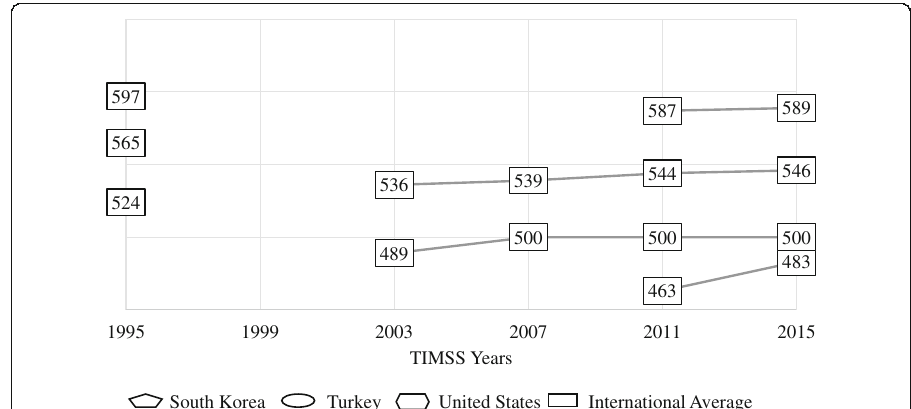
Fig. 1 Fourth Graders ’ Science Achievement in TIMSS in South Korea, Turkey, and the United States. Data indicate the average science achievement scores by country and year (Martin et al., 2012; Martin et al. 2016a). The TIMSS is administered once every four years since 1995. South Korea and Turkey did not participate each year that it was administered. The TIMSS science portion was not offered to fourth grade students in 1999. The international average is the average score of all participating countries ’ science achievement scores accepted by the TIMSS